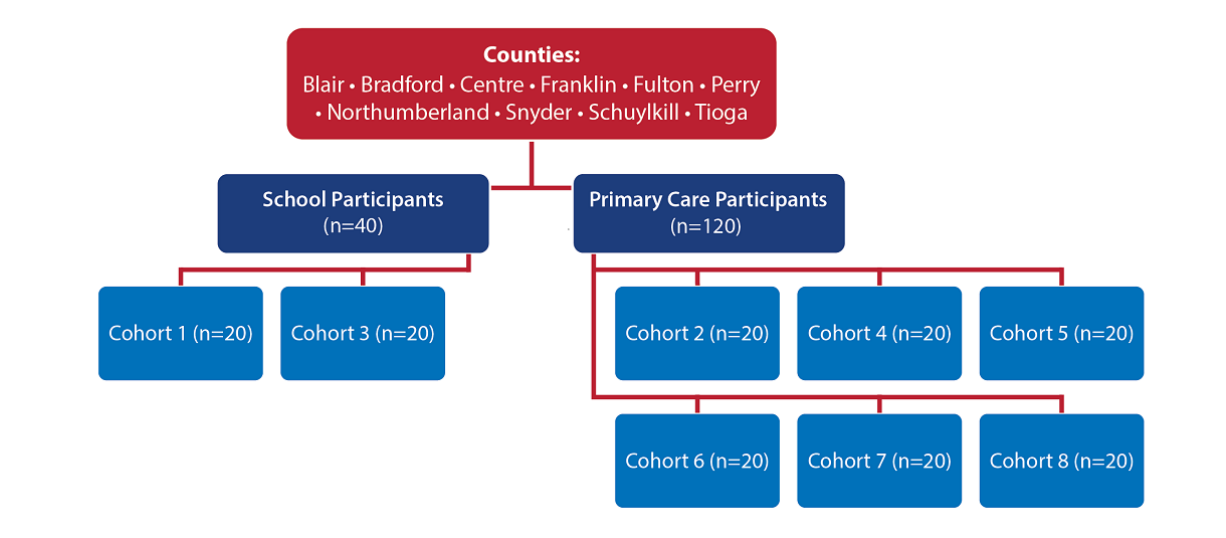
Figure 2. Recruitment into ECHO